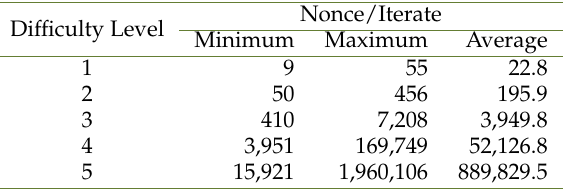
Table 4. Mining Process